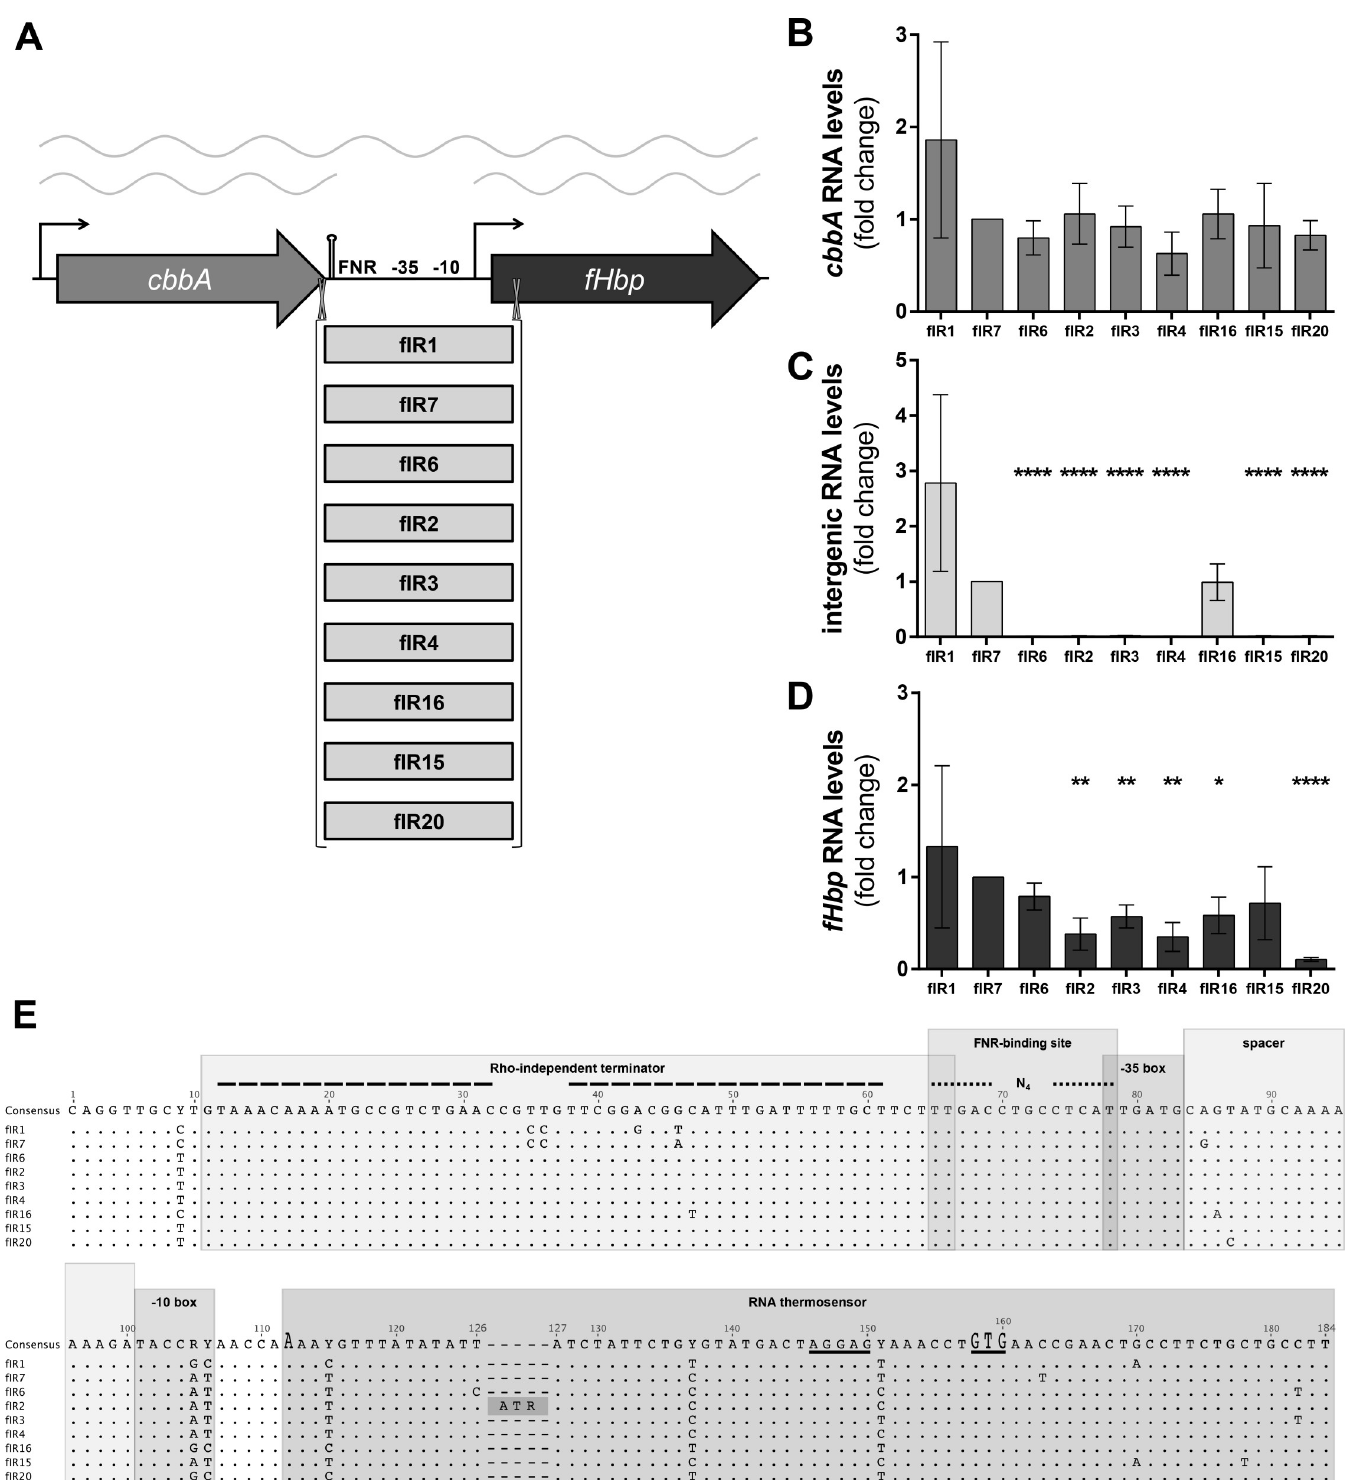
Fig 2. fIR nucleotide sequence determines fHbp expression levels. ( A ) Schematic representation of the locus of fHbp (dark grey) with its upstream cbbA gene (grey) and the transcripts generated from both promoters. The intergenic region (fIR) under investigation and the regulatory elements within it are highlighted: the rho- independent terminator is shown with a stem-loop and the transcriptional start sites of both genes by bent arrows. The set of isogenic recombinant mutants generated in the MC58 background is depicted in light grey. Results of the qRT-PCRs performed on cbbA ( B ), the intergenic region ( C ) and fHbp ( D ) transcripts. mRNA was